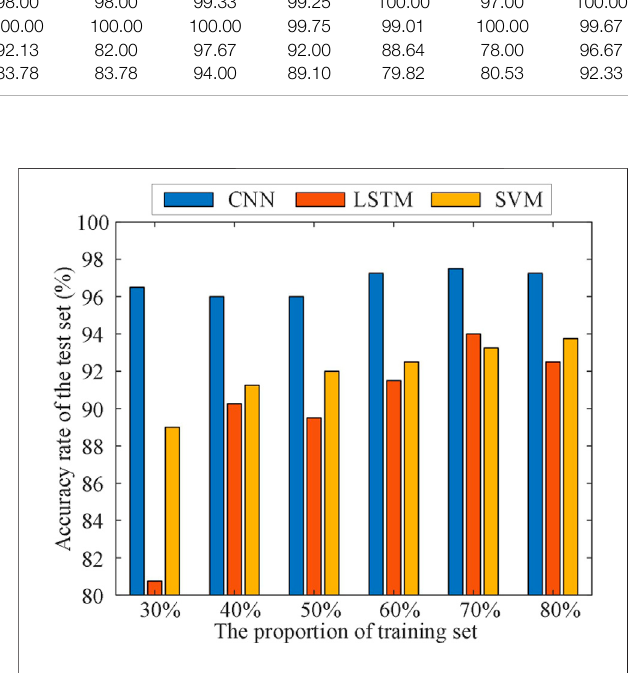
FIGURE 9 | Accuracy rate of validation set. FIGURE 10 | Accuracy rate of test